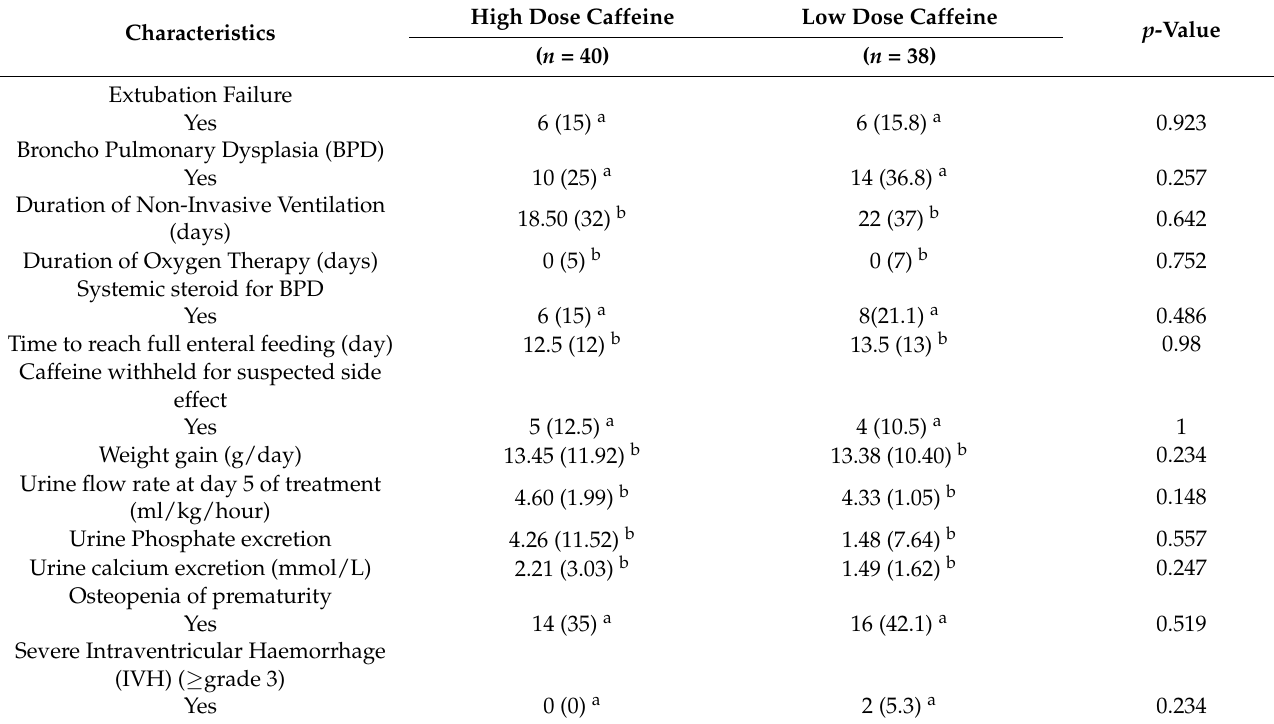
Table 3. Secondary outcome ( n =